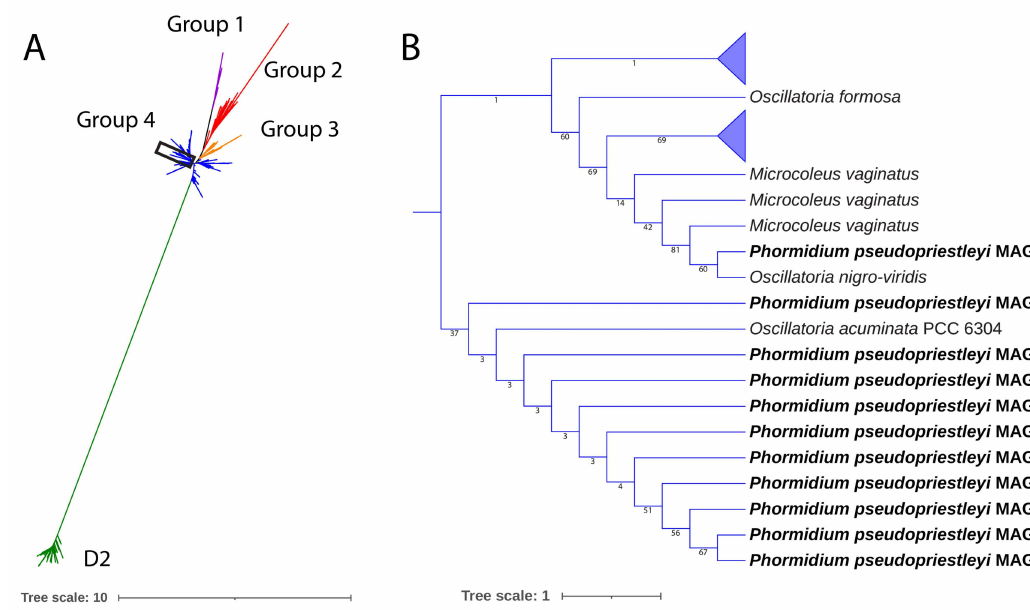
Figure 3. ( A ) a maximum likelihood tree of D1 and D2 proteins of sequences presented in Cardona et al. [25] and the 11 D1 protein fragments in the P. pseudopriestleyi MAG. All P. pseudopriestleyi fragments (enclosed in the rectangle) grouped with group 4 D1 proteins. ( B ) region of the tree showing P. pseudopriestleyi and the most closely related D1